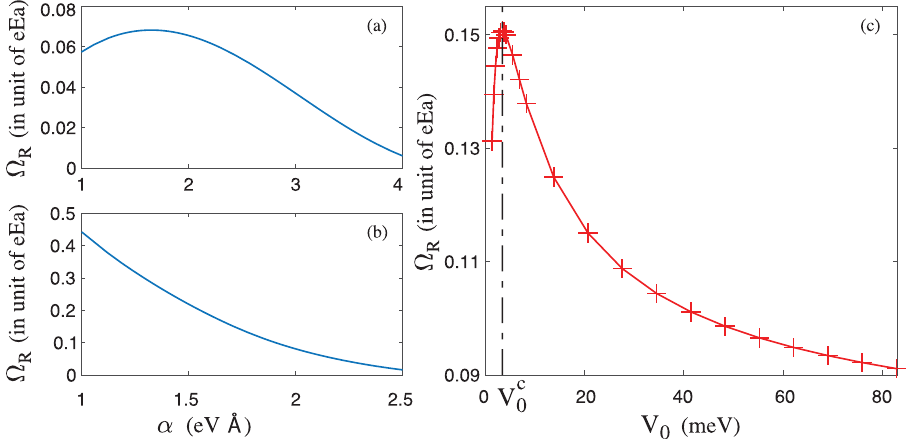
Figure 5. ( a ) The Rabi frequency as a function of the SOC in the ISW. ( b ) The Rabi frequency as a function of the SOC in the FSW. ( c ) The Rabi frequency as a function of the well height V 0 in the FSW. The SOC is fixed at α = 1.8 eV